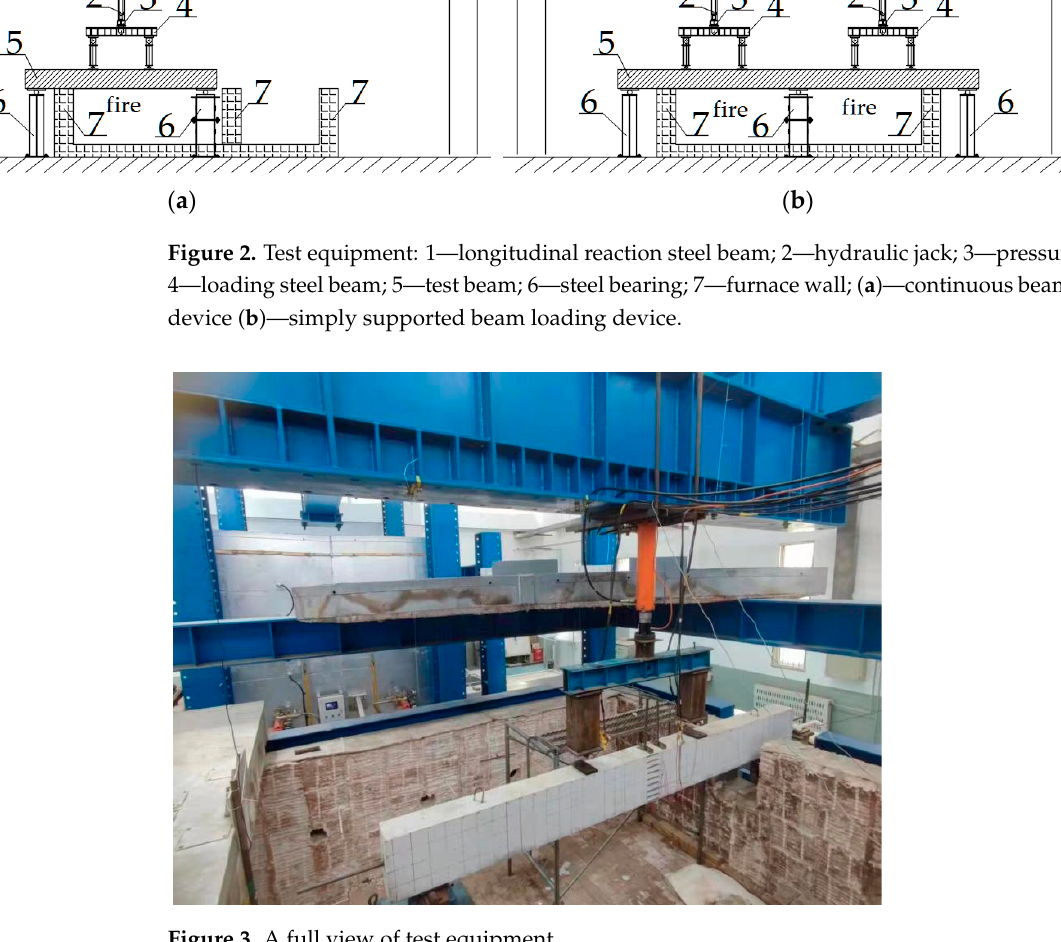
Buildings 2022 , 12 , 1816